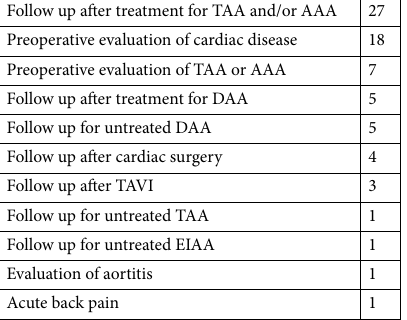
Table 1. Clinical indications for CT in the enrolled patients. TAA thoracic aortic aneurysm, AAA abdominal aortic aneurysm, DAA dissecting aortic aneurysm, EIAA external iliac arterial aneurism, TAVI transcatheter aortic valve